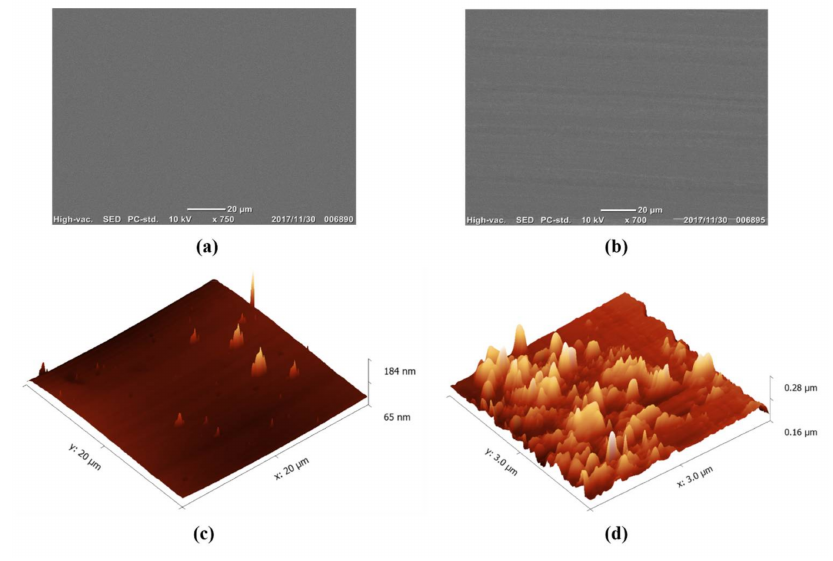
Figure 5. ( a ) SEM images of the nanosheet before the friction measurement and ( b ) after the friction measurement; atomic force microscopy (AFM) images of the nanosheet ( c ) before the friction measurement and ( d ) after the friction